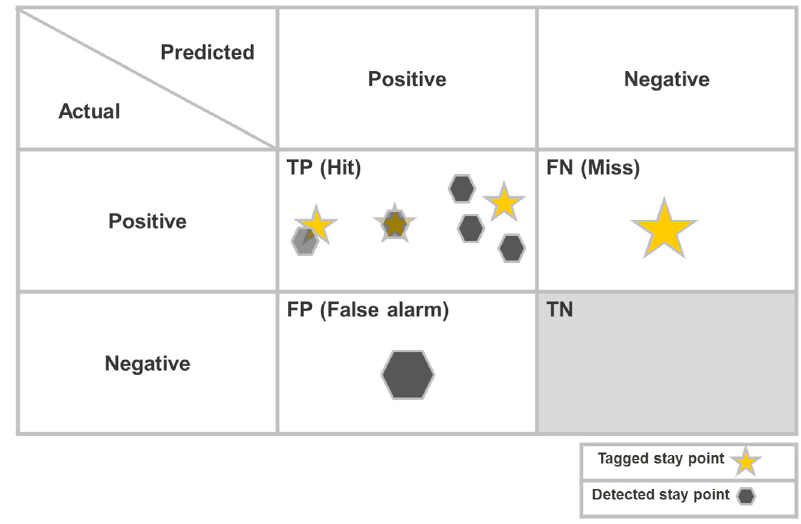
Figure 2. Confusion matrix without true negatives (TN).